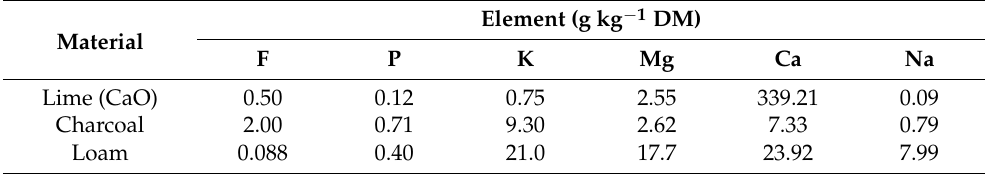
Table 1. Chemical composition of substances added to soil in order to inactivate